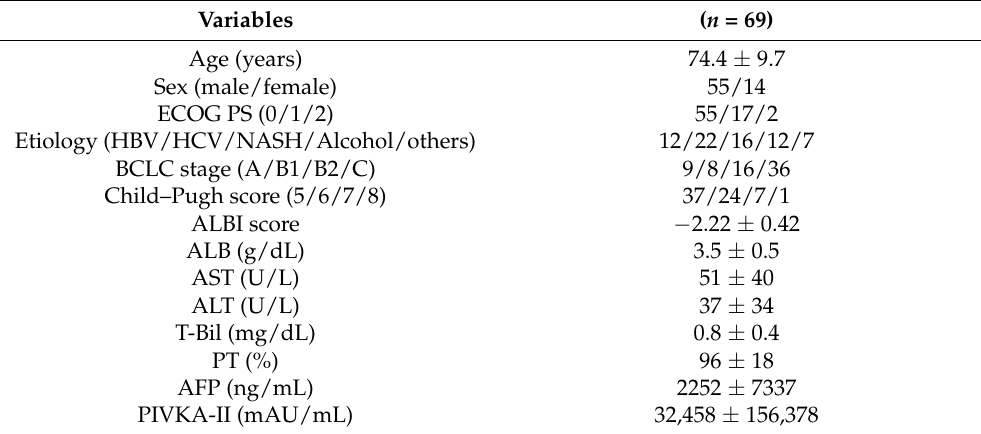
Table 1. Baseline demographic and clinical characteristics of the enrolled